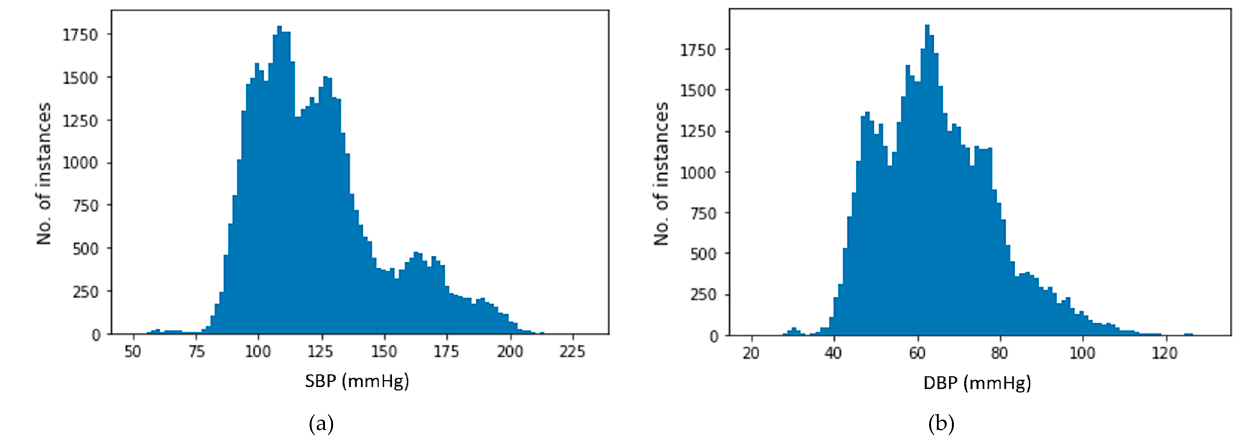
Figure 7. Distribution of ( a )systolic BP (SBP) and ( b )diastolic BP (DBP).